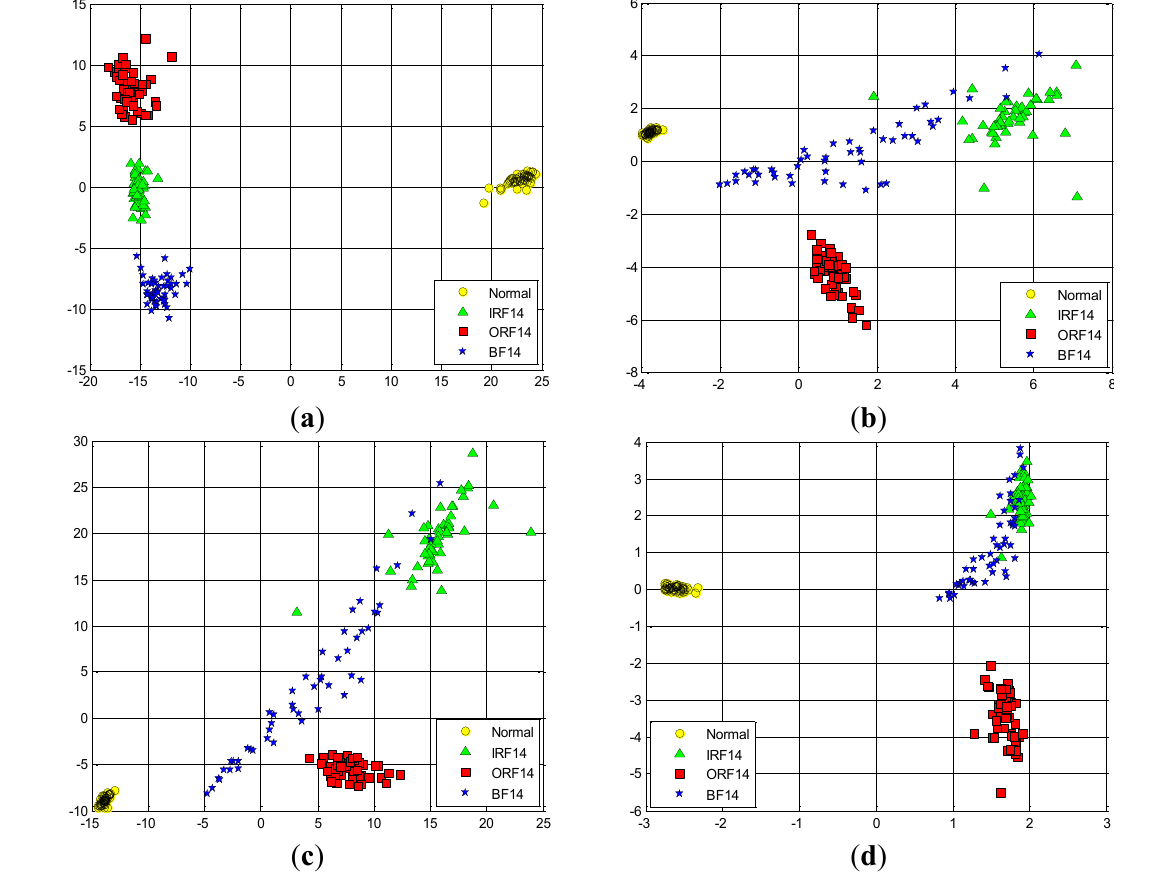
Figure 13. The data projection result with the first two eigenvectors in the D_MIX dataset using: ( a ) SR. ( b ) PCA. ( c ) FA. ( d ) LPP.